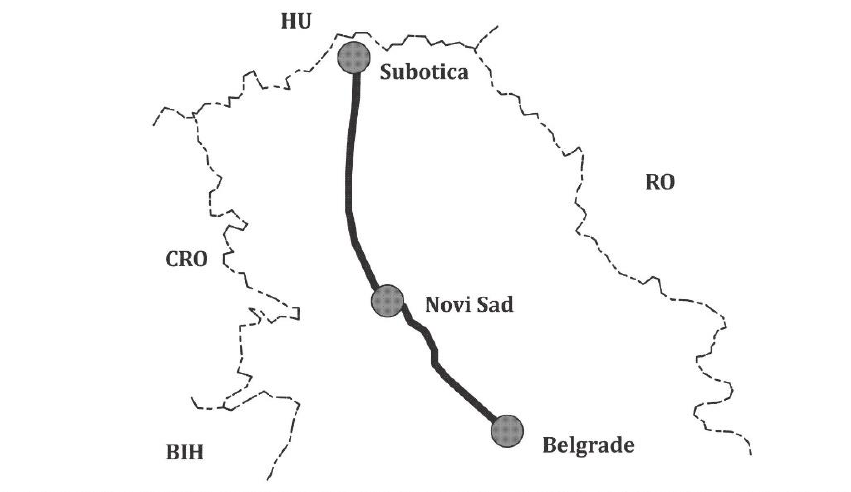
Figure 2. Physical service